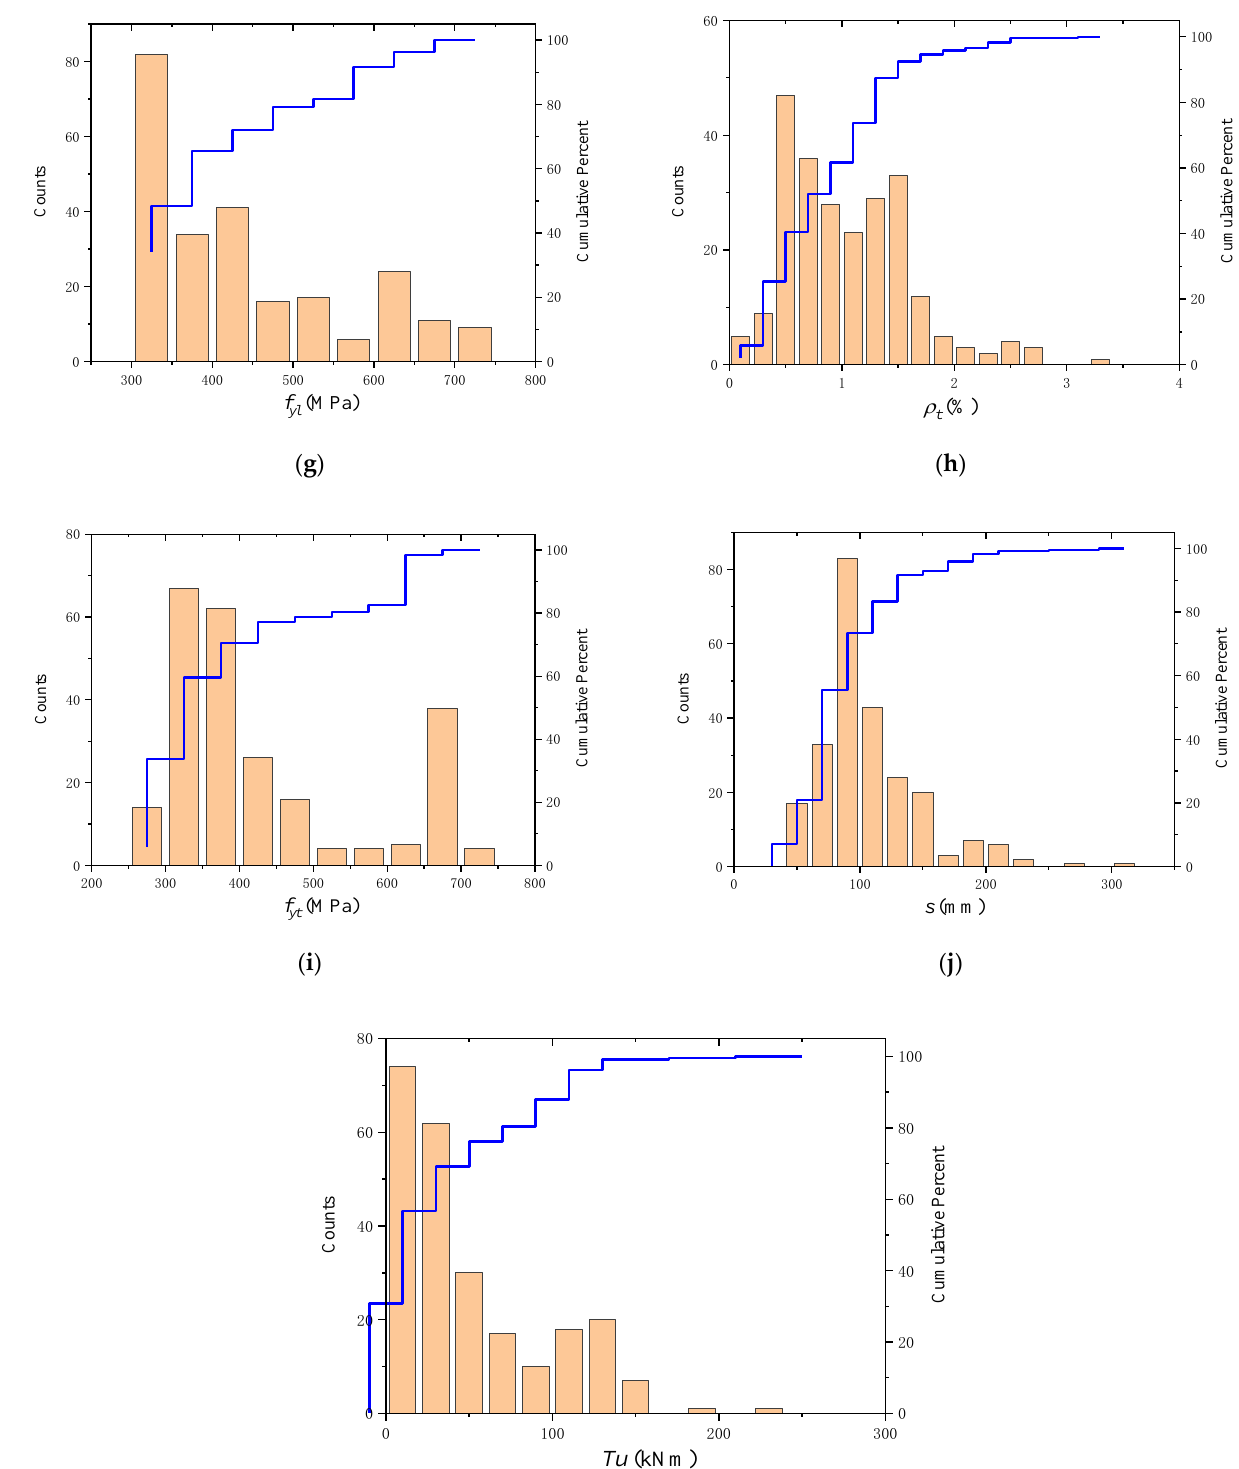
Figure 1. Historical distributions of parameters ( a ) RC beam section’s width ( b ); ( b ) RC beam section’s depth ( h ); ( c ) Closed stirrup width ( b (cid:48) ); ( d ) Closed stirrup depth ( h (cid:48) ); ( e ) Compressive strength ( f c (cid:48) ); ( f ) Longitudinal reinforcement ratio ( ρ l ); ( g ) Yield strength of the longitudinal reinforcement ( f yl ); ( h ) Transverse reinforcement ratio ( ρ t ); ( i ) Yield strength of transverse reinforcement ( f yt ); ( j ) Closed stirrup spacing ( s ); ( k ) Torsional strength ( T n